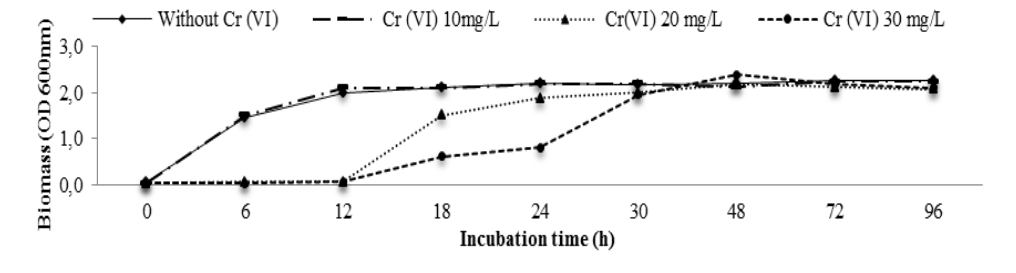
Fig. 2. Biomass growth of Enterobacter sp. HT 1 (indicated by OD value) in LB broth with and without Cr (VI).